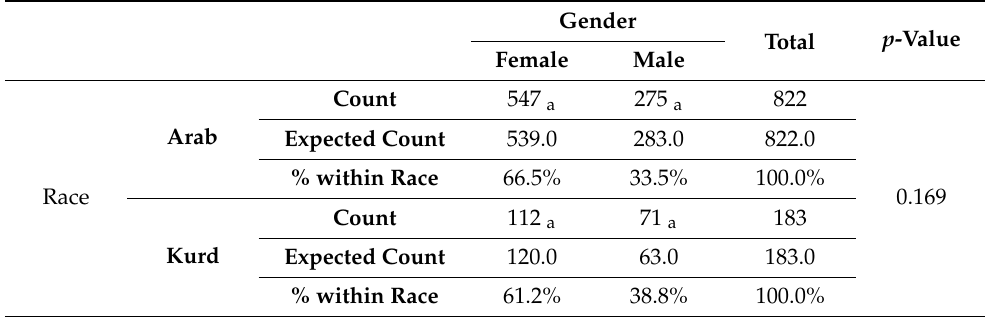
Table 3. Descriptive statistics and comparison of gender distribution between races (chi-square test).